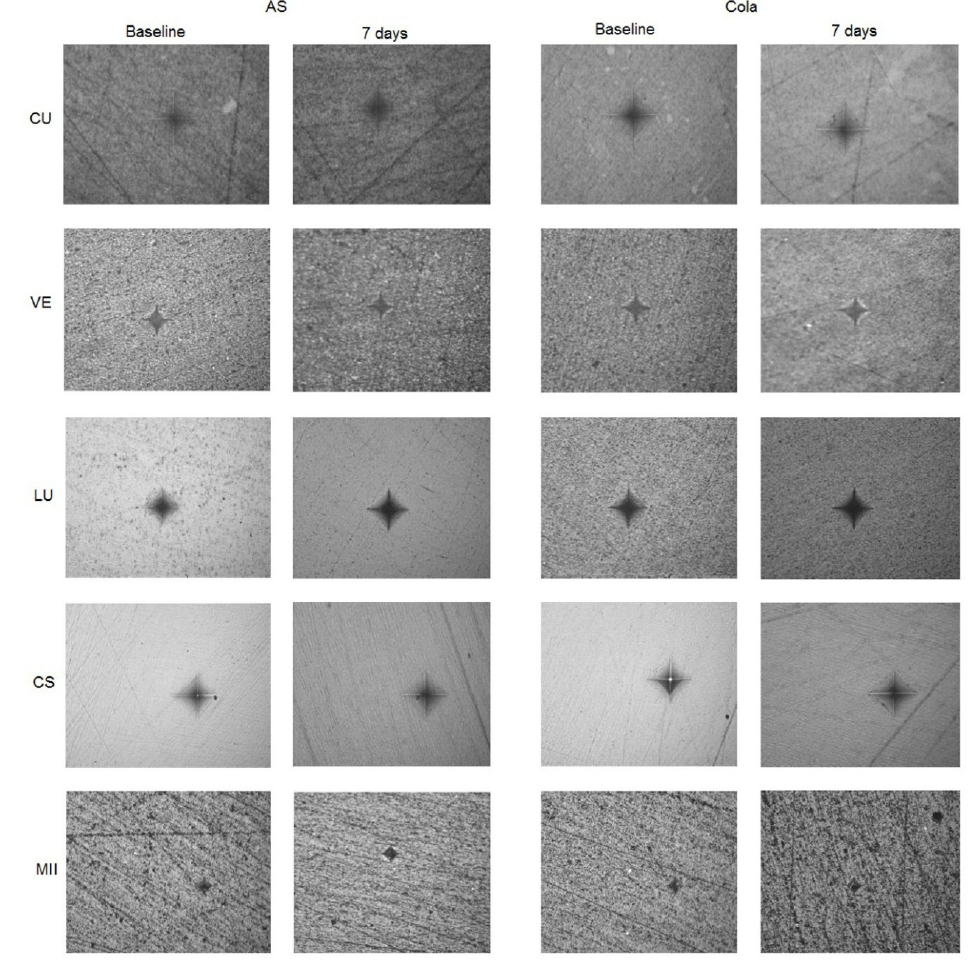
Figure 3. Vickers indentation images (×40) of the CAD/CAM specimens at baseline and after immersion in either AS or Cola.